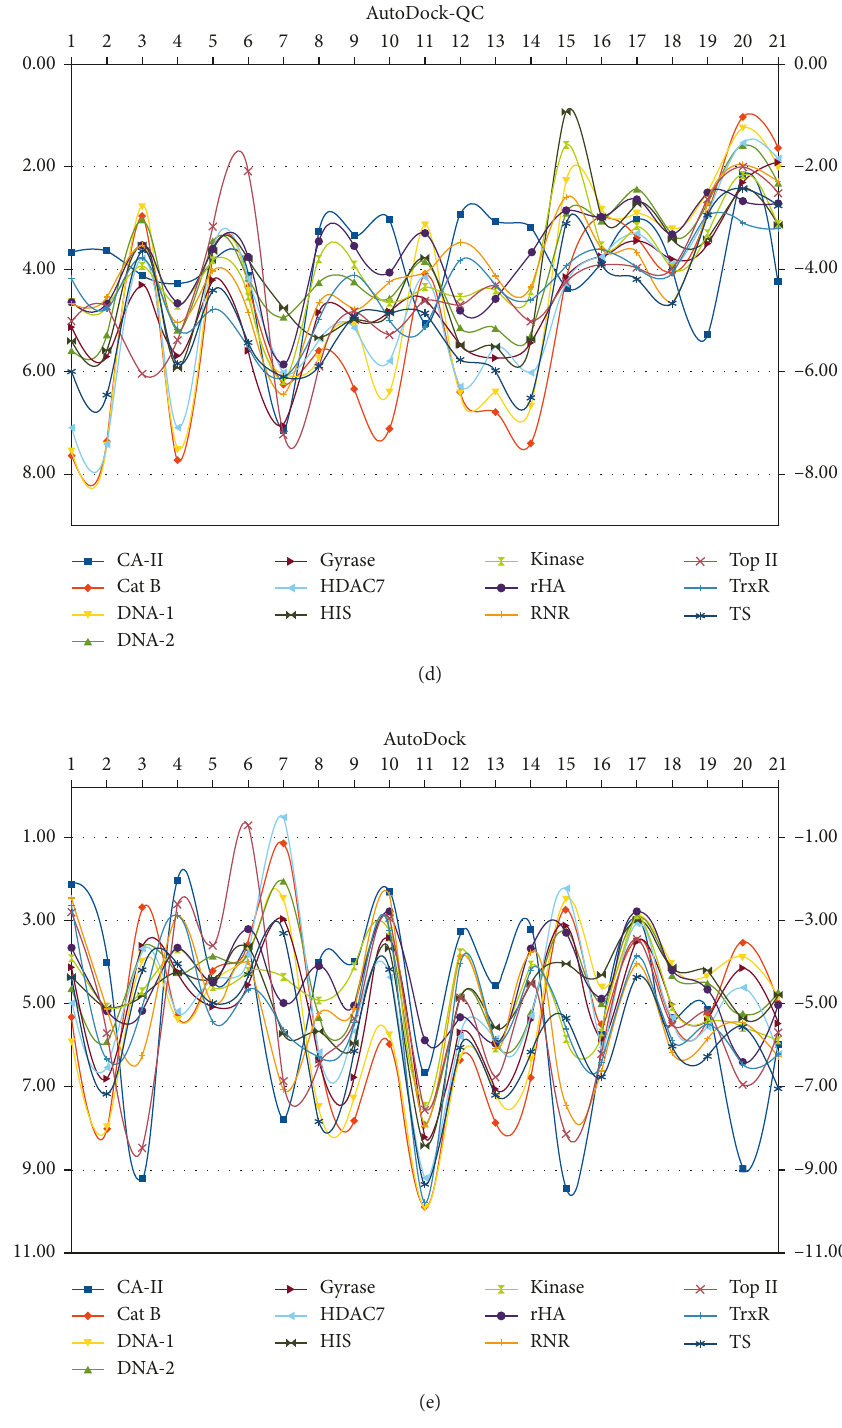
Figure 3: The plots of the energy of interaction of the ligands with each of the receptors using the five HDAC7, HIS, Kinase, rHA, RNR, Top II, and TS (Figure 4). while the interactions of each of the compounds 7 , 11 , and The few exceptions to these common interaction features are 15 with each of the receptors are shown in supplementary found in the receptors DNA-1 and TrxR (Figure 4). A Figure S1. In most of the receptors, the three compounds 7 different binding site was predicted for the interaction of 11 (grey), 11 (green), and 15 (yellow) are found to be clustering with DNA-1 where 7 and 15 have inner groove interaction around the same point and sharing common angles of in- but the interaction of 11 is out of groove. In addition, the teraction with the receptors CA-II, Cat B, DNA-2, Gyrase,